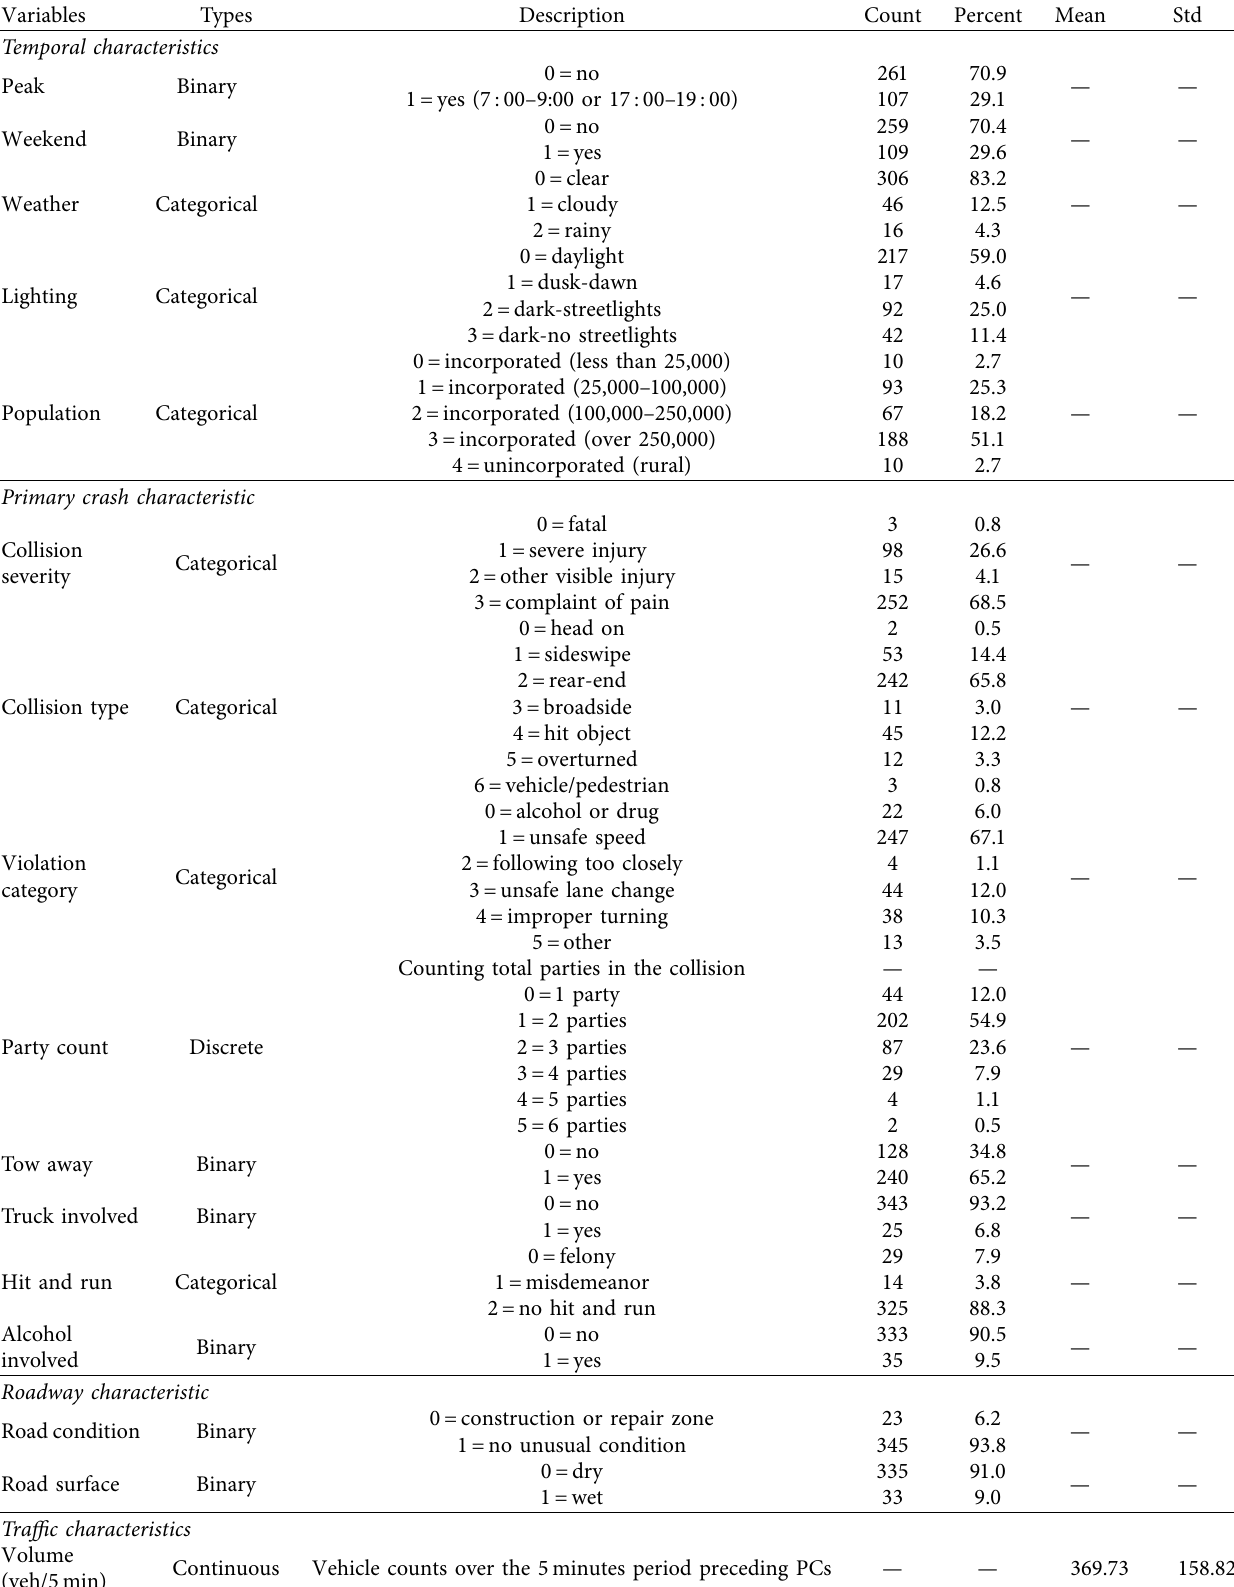
Table 1: Description of variables used in crash